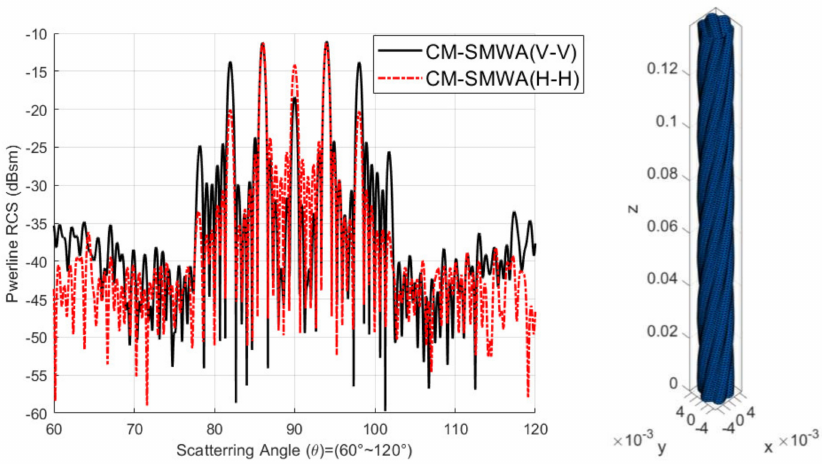
Figure 16. Simulation results of the H-H polarization vs. V-V polarization at 94 GHz.